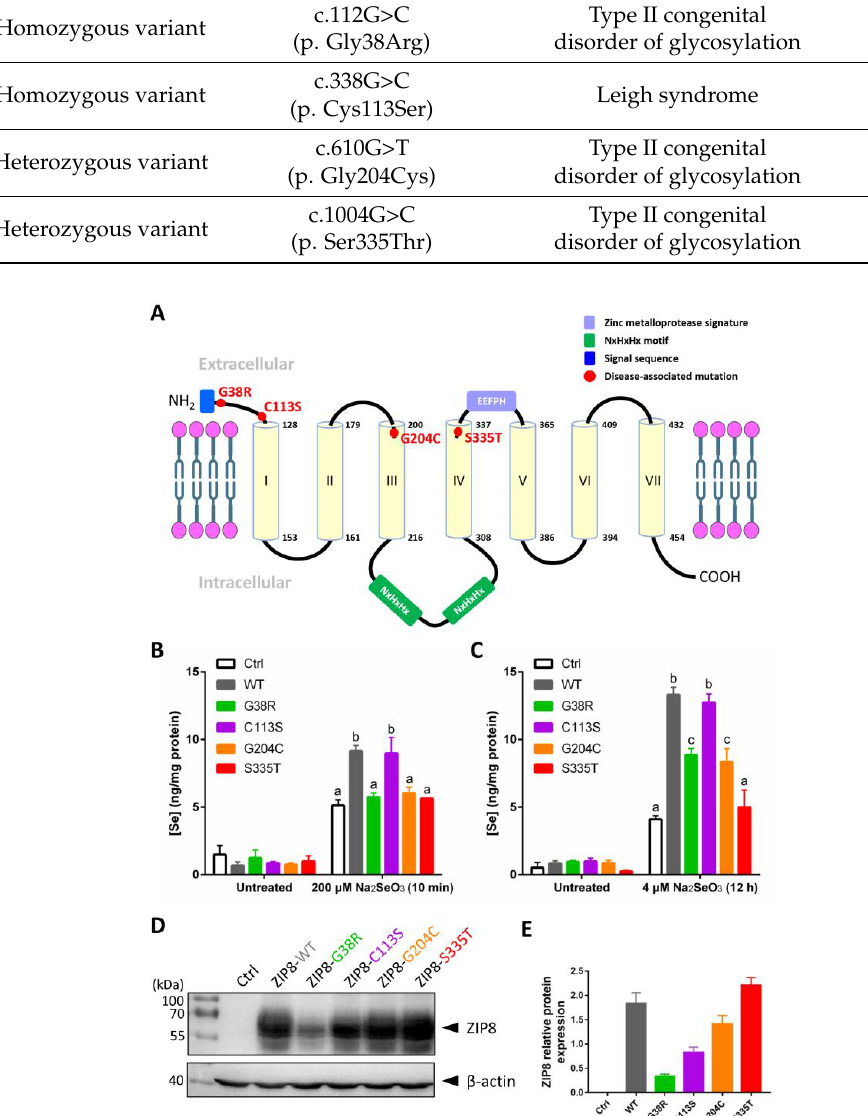
Table 1. Information of selected disease-associated ZIP8 single-point mutations examined in this study.